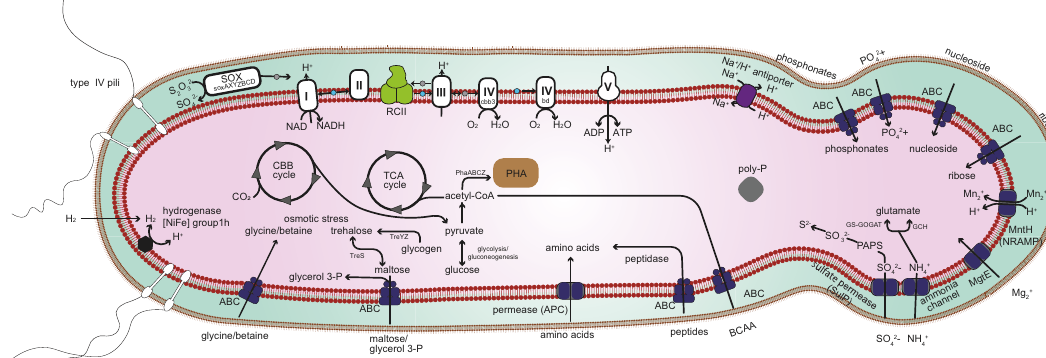
Fig. 2 Metabolic reconstruction based on the genome of strain WC8-2. I, NADH dehydrogenase; II, succinate dehydrogenase/fumarate reductase; III, cytochrome bc1 complex; IV cbb3, cbb3-type cytochrome c oxidase; IV bd, cytochrome bd quinol oxidase; V, F-type ATPase; RCII, photoreaction center II; SOX, sulfur/thiosulfate oxidation protein complex; ABC, ABC transporter; APC, amino acid/polyamine/organocation superfamily; NRAMP, natural resistance-associated macrophage proteins; PHA, polyhydroxyalkanoates; Poly-P, polyphosphate granule. Gray and blue circles represent cytochrome c proteins and quinones, respectively. Identi fi cation of genes associated with pathways in this overview is given in Supplementary Table pink colonies. Despite being aerobic, WC8-2 did not grow in a BIO- SILICO N-38 sponge plugged culture in the presence of air (100%) or in the absence of CO 2 (N 2 /O 2 /CO 2 [80:20:0%]) under a 12/12 h light/ dark regime, demonstrating that it requires a high CO 2 concentra-